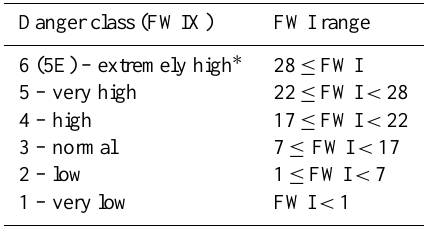
Table 1. Range of FWI (Fire Weather Index) for fire danger classes in